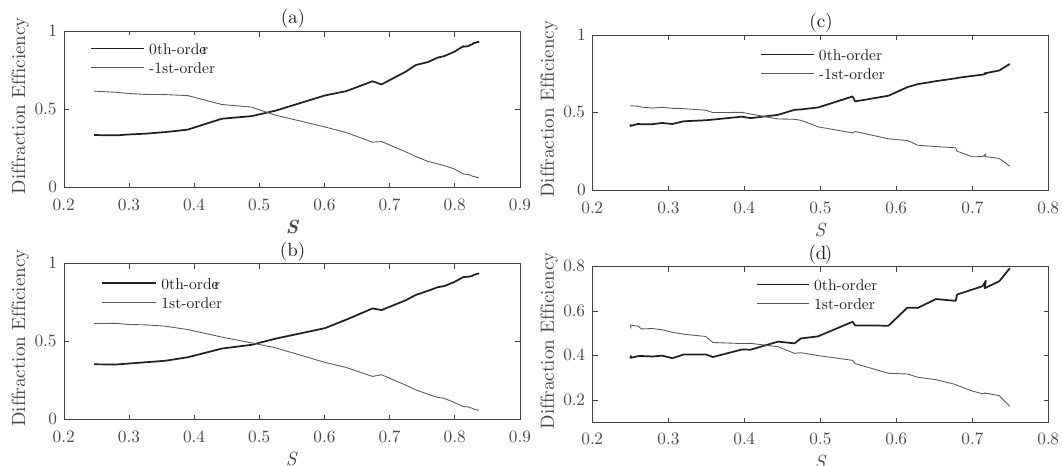
Figure 8. For Grating #1, diffraction efficiency as a function of the S parameter for θ inc = 18.34 ◦ (Bragg angle). Graphs ( a , c ) compare the 0th-order with the − 1st-order and ( b , d ) the 0th-order and the 1st-order. ( a , b ) represent the results for droplets between 50 and 100 nm on average; ( c , d ) represent the results for droplets between 75 and 150 nm.